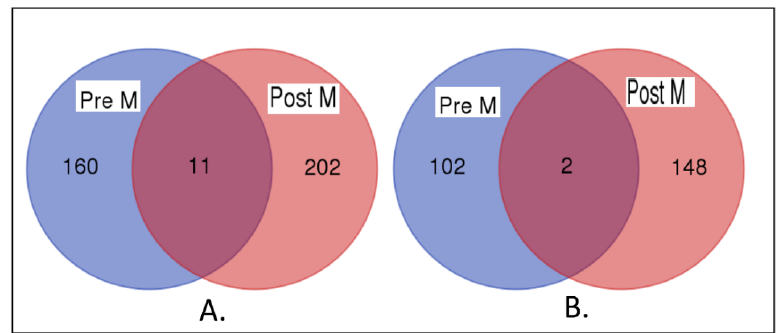
Figure 2. Venn diagrams showing overlap and lack thereof between premenopausal and postmenopausal women for genes associating ( A ) obesity or ( B ) overweight status with TNBC. Pre M and Post M denote premenopausal and postmenopausal,